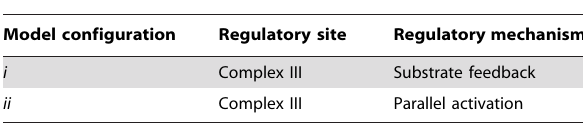
Table 2. Summary of model configurations. Table 3. Parameter values model configuration i , substrate feedback at complex III.